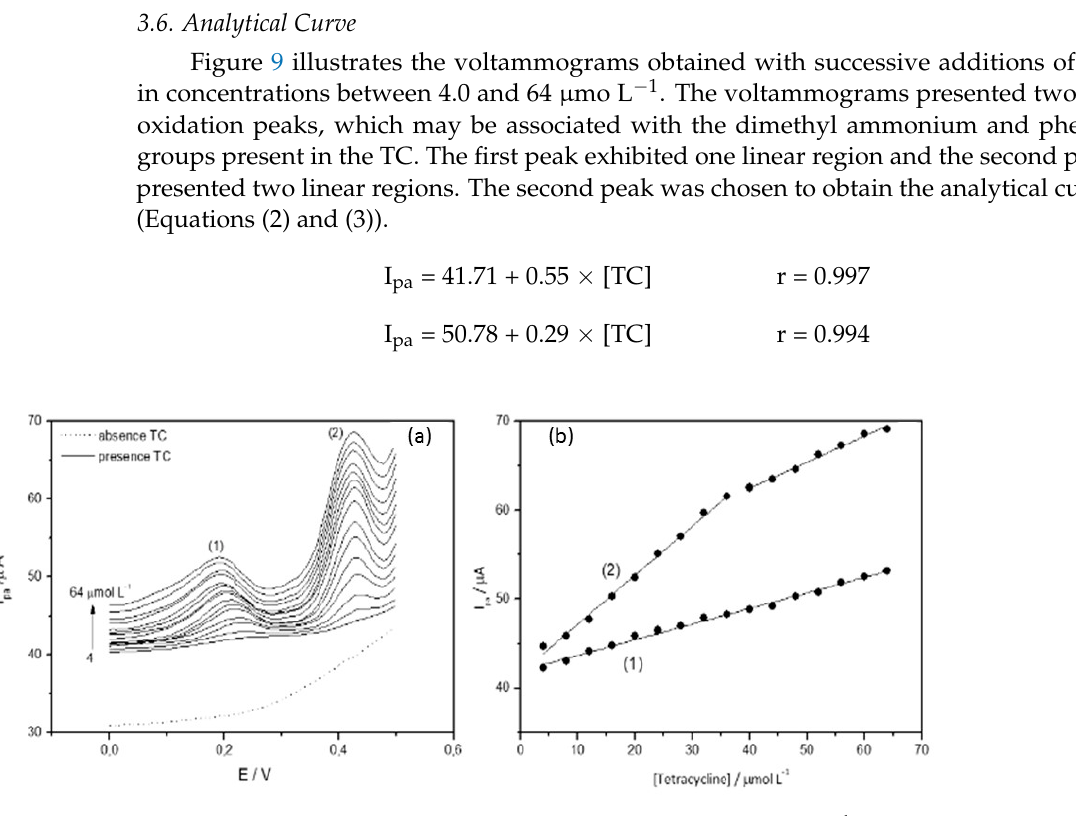
Table 2. Comparison of the proposed sensor with other methods described in the literature.